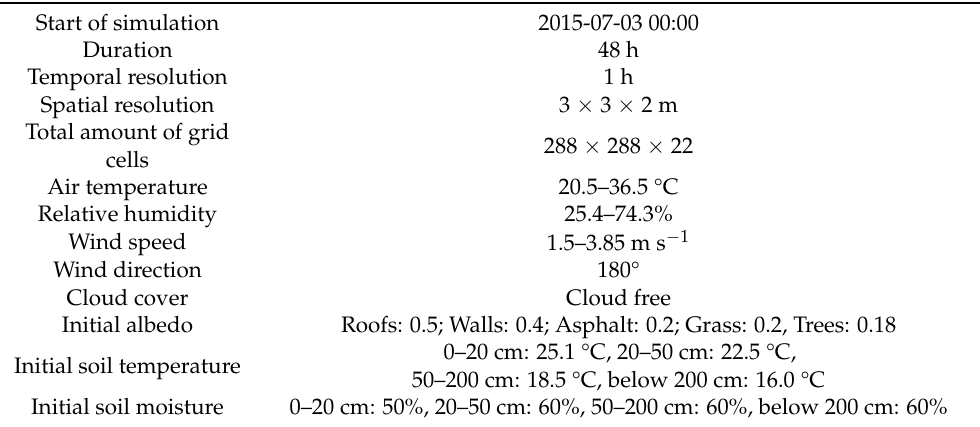
Table 1. Input parameters specified in the ENVI-met input file and guiding the performed